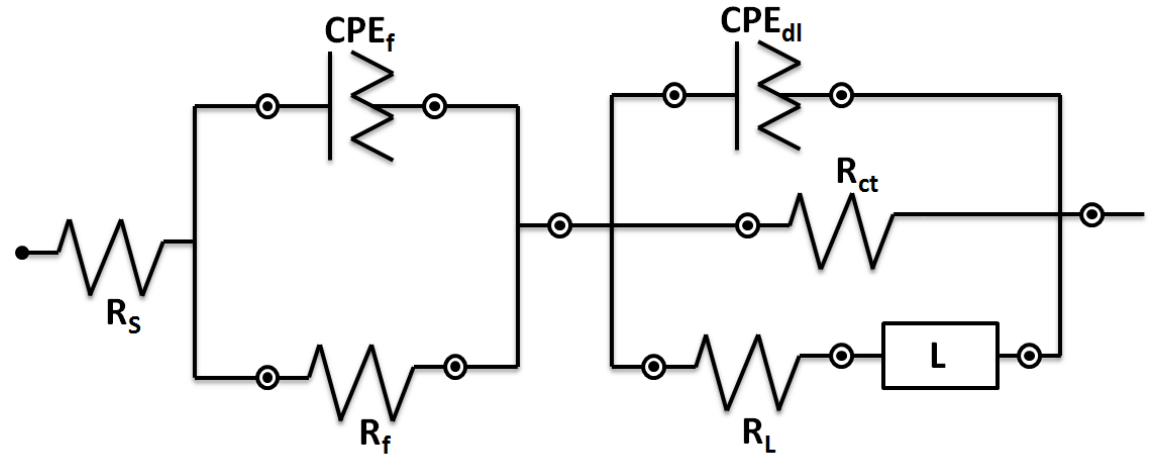
Page 12 Figure 11: The figure contain typo and should replace with modified version.